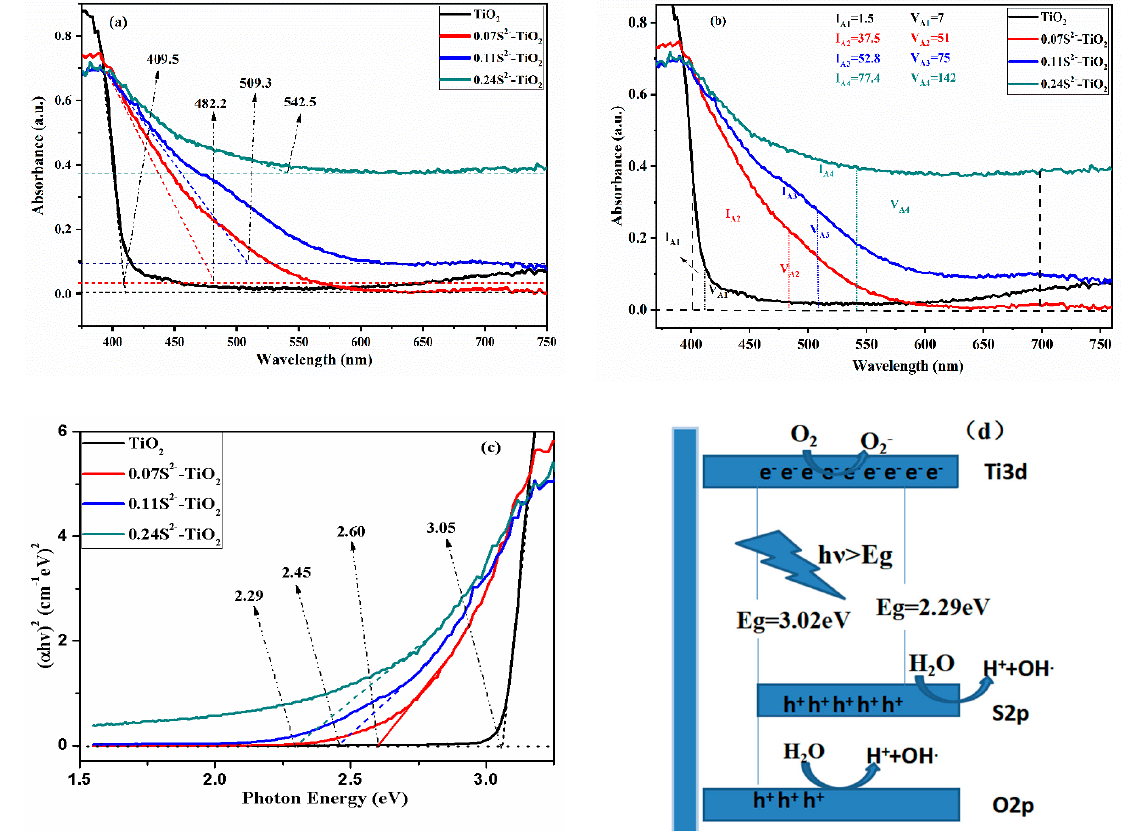
Figure 6. ( a ) UV-Vis of S 2 − -doped TNA with di ff erent atomic percentage. ( b ) IA and VA of S 2 − -doped TNA with di ff erent atomic percentage. ( c ) The determination of the absorption edges of the samples. ( d ) Schematic diagram of the 0.24S 2 − -TiO 2 and charge separation of system under visible light. Table 3. Comparison of UV-vis absorption optical spectrum and bandgap of S-doped TiO 2 . Photocatalyst (Ref.)